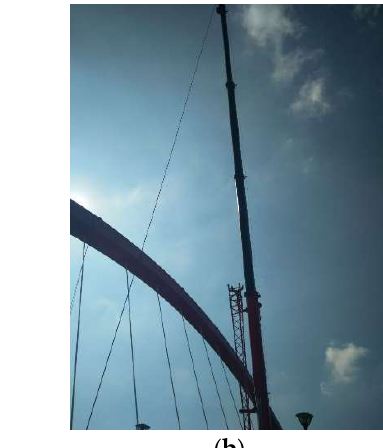
Figure 16. The change of the boundary condition: ( a ) before the 17th day (5 April 2017); ( b ) after the 17th day (5 April 2017).